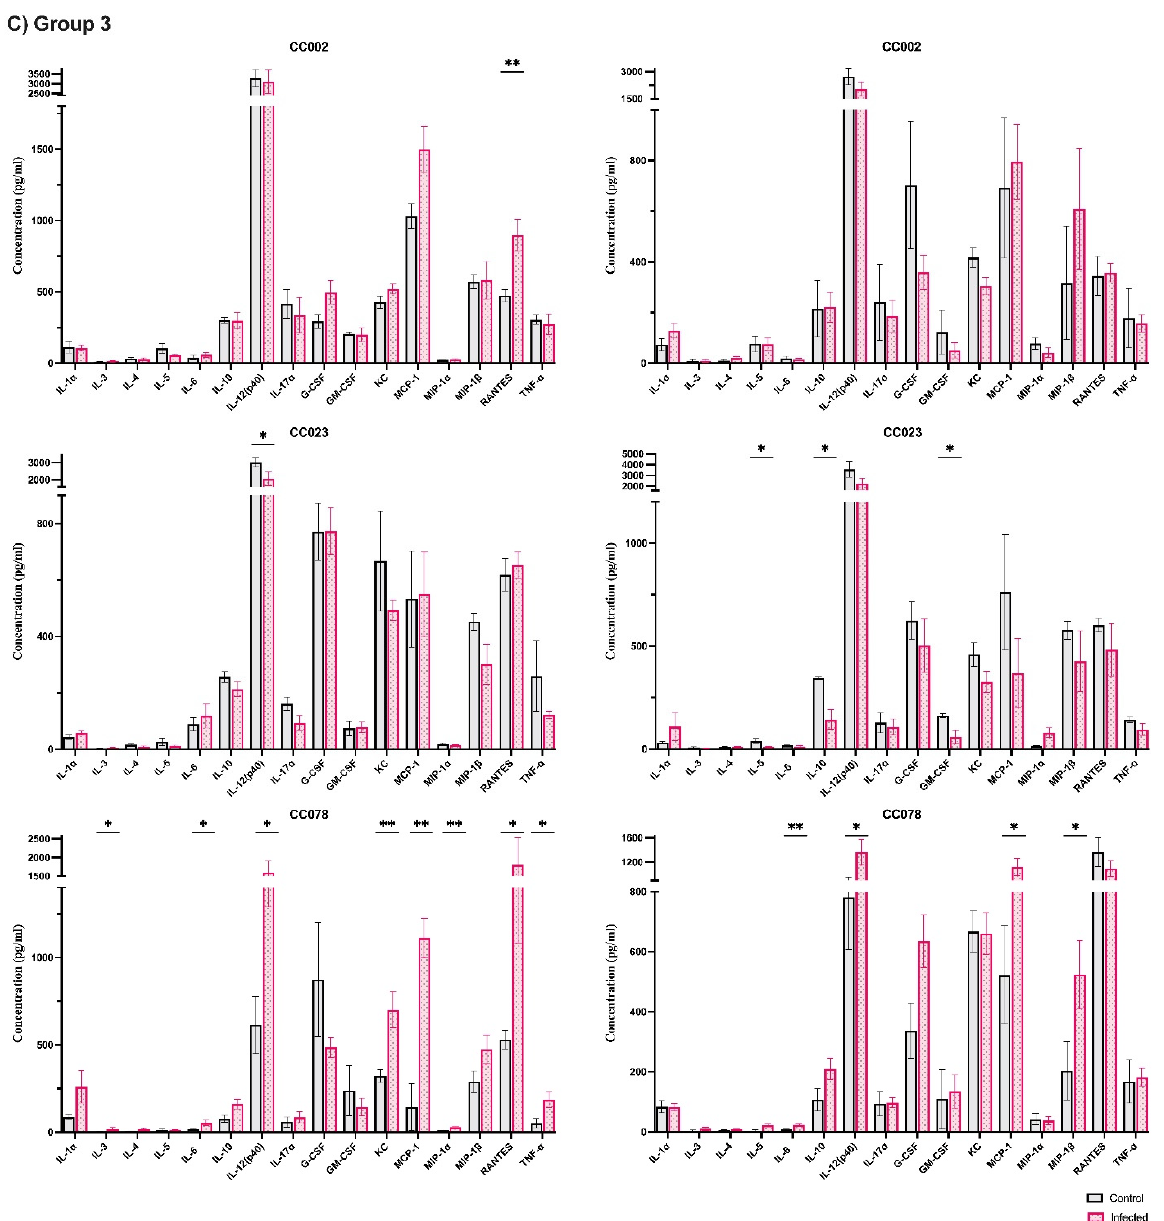
Figure 4. Summary snapshot of cytokines and chemokines significantly produced in response to TMEV at two time points post-injection. Strain-specific cytokines and chemokines were produced at significantly different levels in infected compared to PBS-injected mice (Mean ± S.E.M.; * p < 0.05, ** p < 0.01, *** p < 0.001). We classified the strains according to their phenotypic response to TMEV, as described in the legend of Figure 3: Group 1 ( A ), Group 2 ( B ), and Group 3 ( C ). The 23 cytokines and chemokines measured at 4 and 14 d.p.i. are available in Supplementary Figure S2A–D (23 cyto/chemokine levels for pre- and post-injection time points).